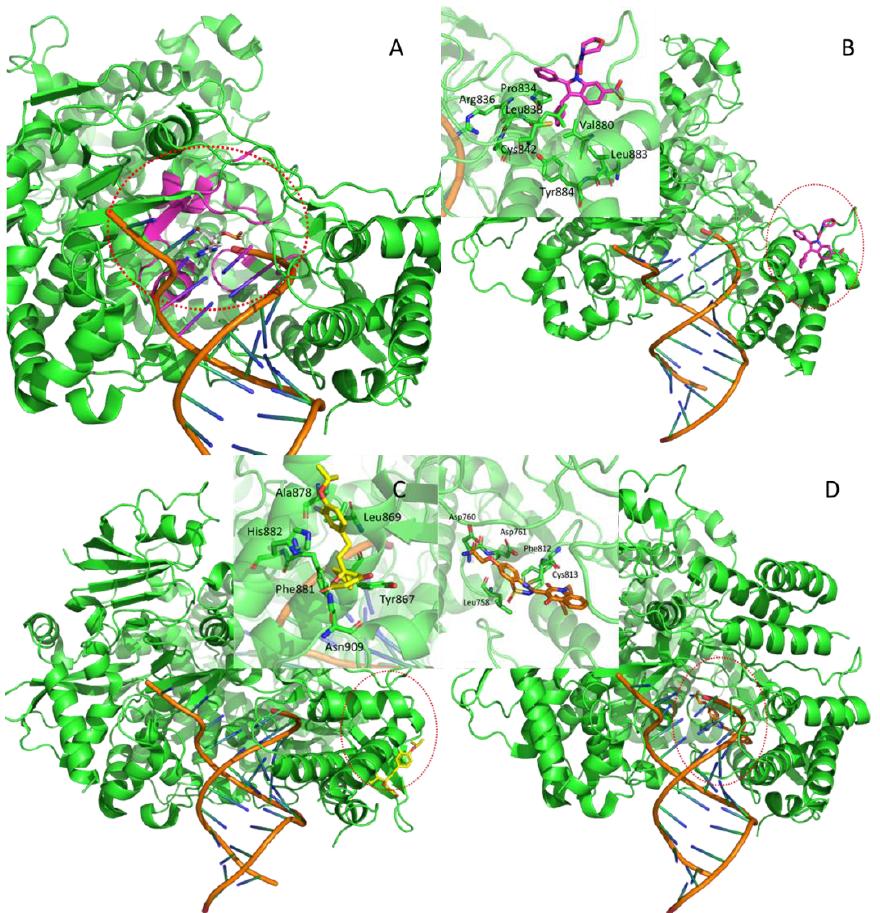
Figure 1. Identified binding sites within the resolved nsp12 structure (PDB Id: 7BV2): the orthosteric cavity in complex with remdesevir ( A ) plus three potential allosteric sites, among which two are located on the “thumb” as defined in their putative complexes with POO ( B ) and PFI ( C ) plus one site on the palm in the predicted complex with 77Z ( D ).